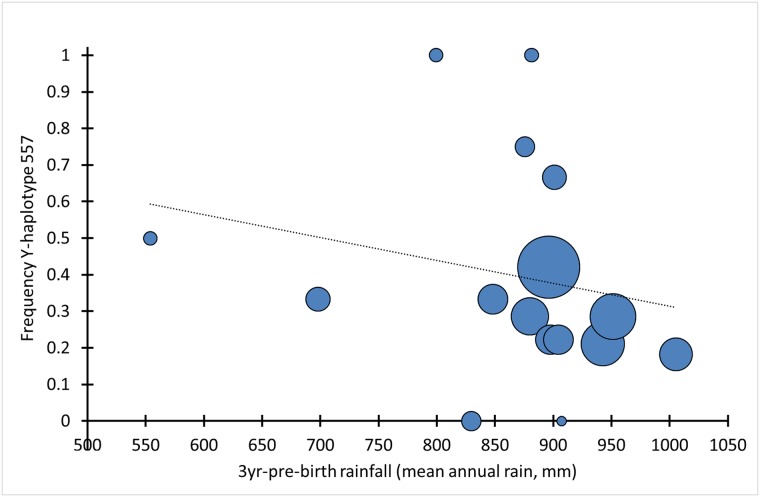
Negative correlation between Y-haplotype-557 frequency and 3-yr-pre-birth rainfall.Area of data points is proportional to sample size, range: 1–38; ρ = -0.51, P = 0.043, Nbirth-year-cohorts = 16, Nindividuals = 157. Test 6, Table 2.